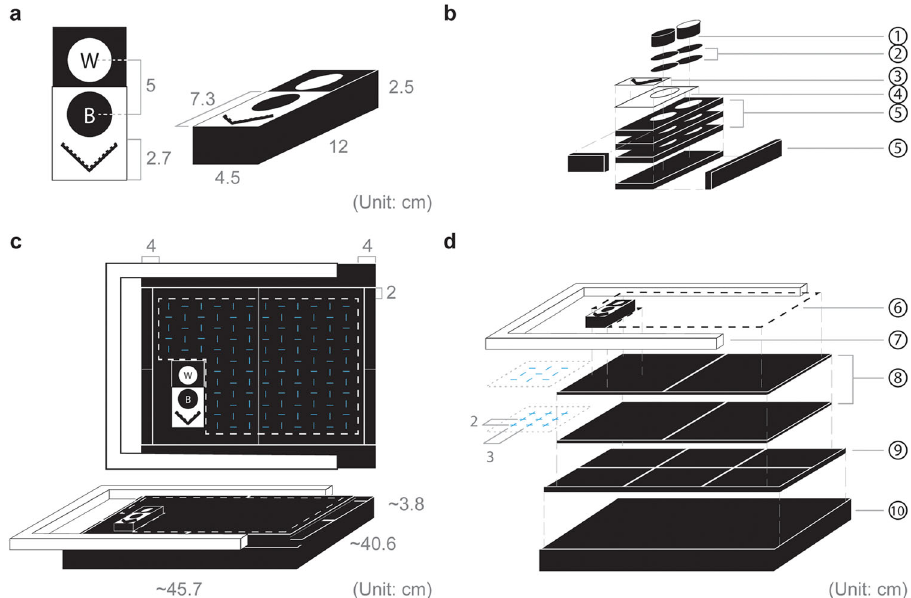
Fig. 6 The design of the imaging platform. a Reference bar and b Corresponding materials. c Imaging platform with the hidden pre-cut slots shown in blue and d Corresponding materials. (1) Black (spectralon black standard AS-001160-960, Labsphere) and white (spectralon white standard AS-001160-060, Labsphere) standard references; (2) Hook loop strips with adhesive (2.4 ″ × 2.4 ″ ); (3) Adhesive forensic evidence labels (2 cm measure; A-6243); (4) Adhesive tear resistant waterproof photo craft paper; (5) Neoprene sponge black foam pads with adhesive (12 ″ × 8 ″ × 1/4 ″ ); (6) Black cotton thread;